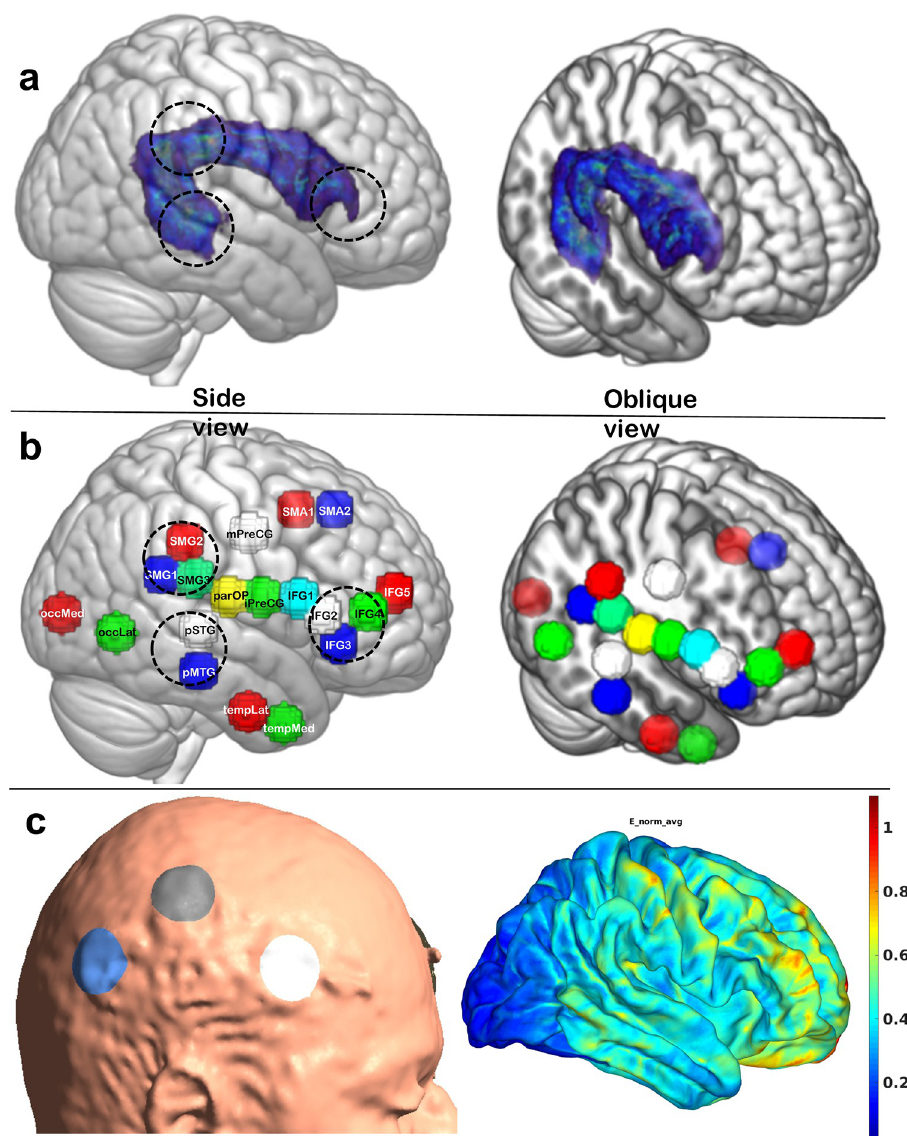
Fig 2. (a) Representative image of the right hemispheric Arcuate Fasciculus tract shown in standard brain and the canonical location of three nodal regions of the AFN targeted by brain-stimulation (dashed circles in 2a). tDCS electrodes were placed on the scalp directly above the brain regions marked with circles. (b) Anatomically identified spherical ROIs representing cortical regions within and outside of the AFN (shown here for the right hemisphere, but mirror left hemisphere regions were identified as well). Side and oblique views are shown to demonstrate the mesial location of AF tract and ROIs. (c) Shows electrode placement for ME montage for one of the participant and Electric field distributions simulated using SimNIBS software